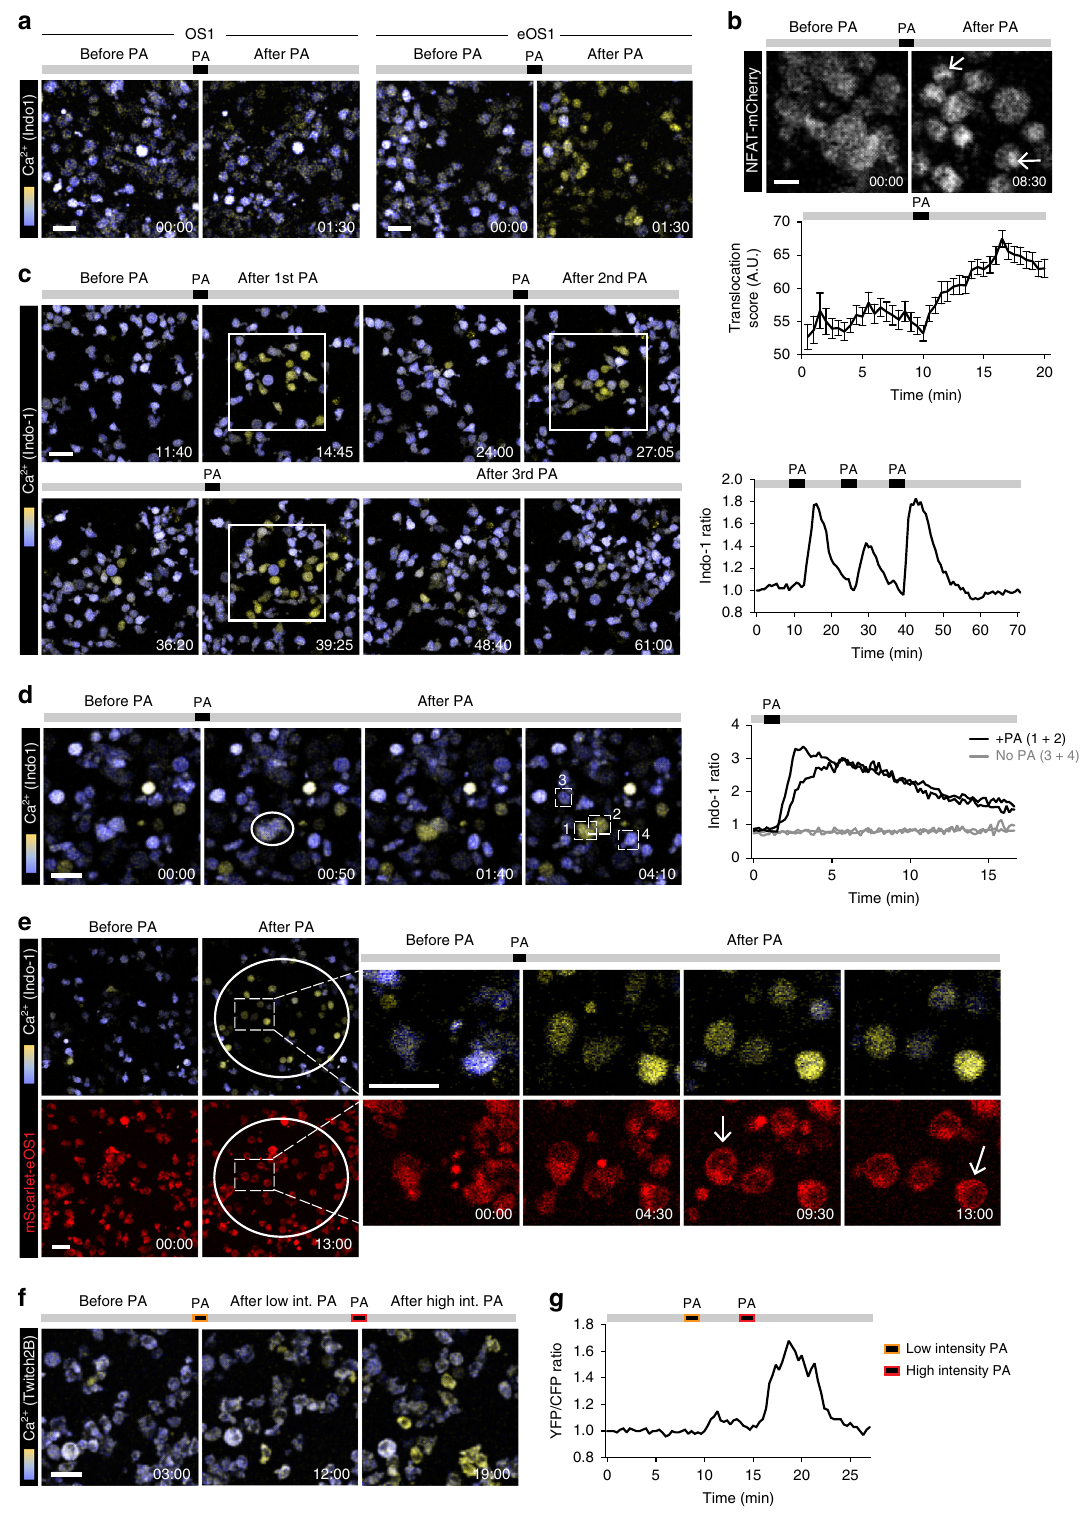
(CETEA) under the protocol code of CETEA 2013-0089. B3Z T cell hybridoma contains the LacZ reporter gene driven by the transcriptional control of NFAT elements 29 . The β -galactosidase activity can be measured by the hydrolysis of the chromogenic substrate CPRG. Plasmids . The nucleotide sequence coding for the fusion protein eGFP-Cry2PHR (1-498)-humanStim1(238 – 465) (OS1) 16 , the D387A inactive mutant (OS1-mut),